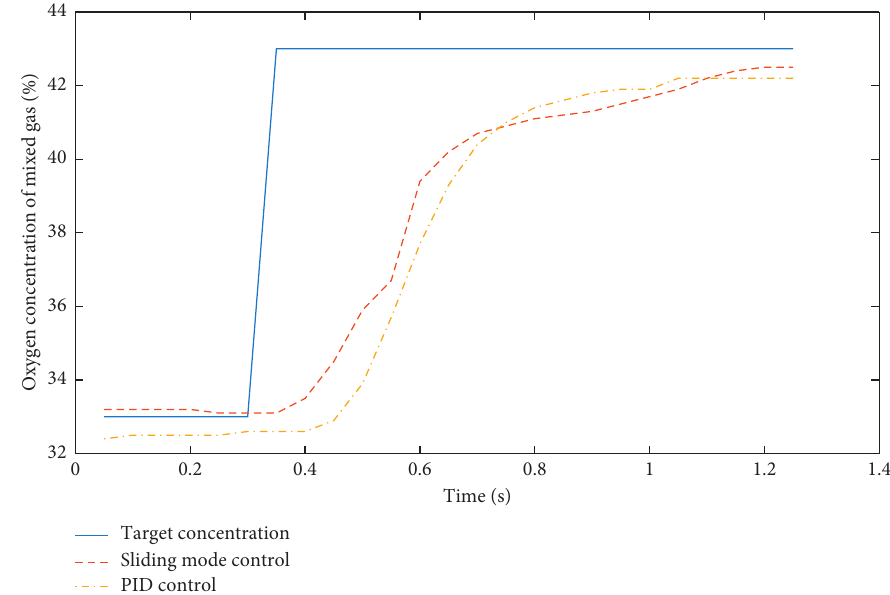
Figure 7: Comparison of actual gas oxygen concentration in the range of